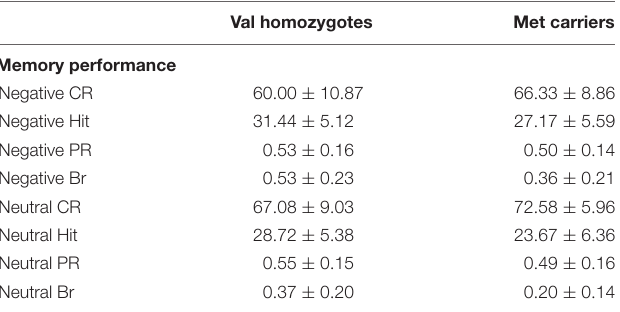
TABLE 2 | Memory performance according to genotype group in Experiment